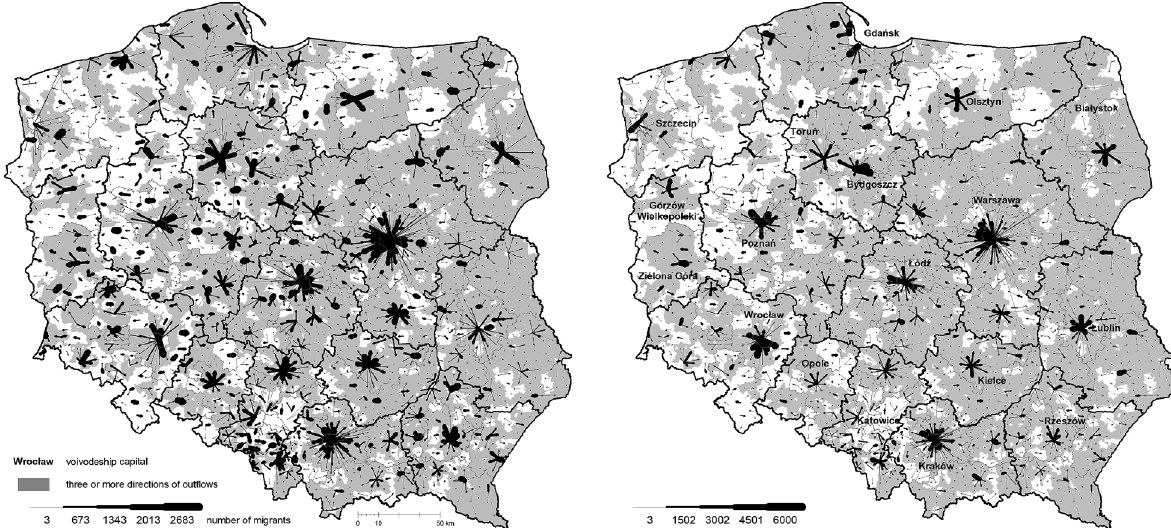
Fig. 3. Areas of migratory attractiveness presented on the scale of migratory movement catchment areas (left) and after trimming off the highest 14 movement values (right) (linear